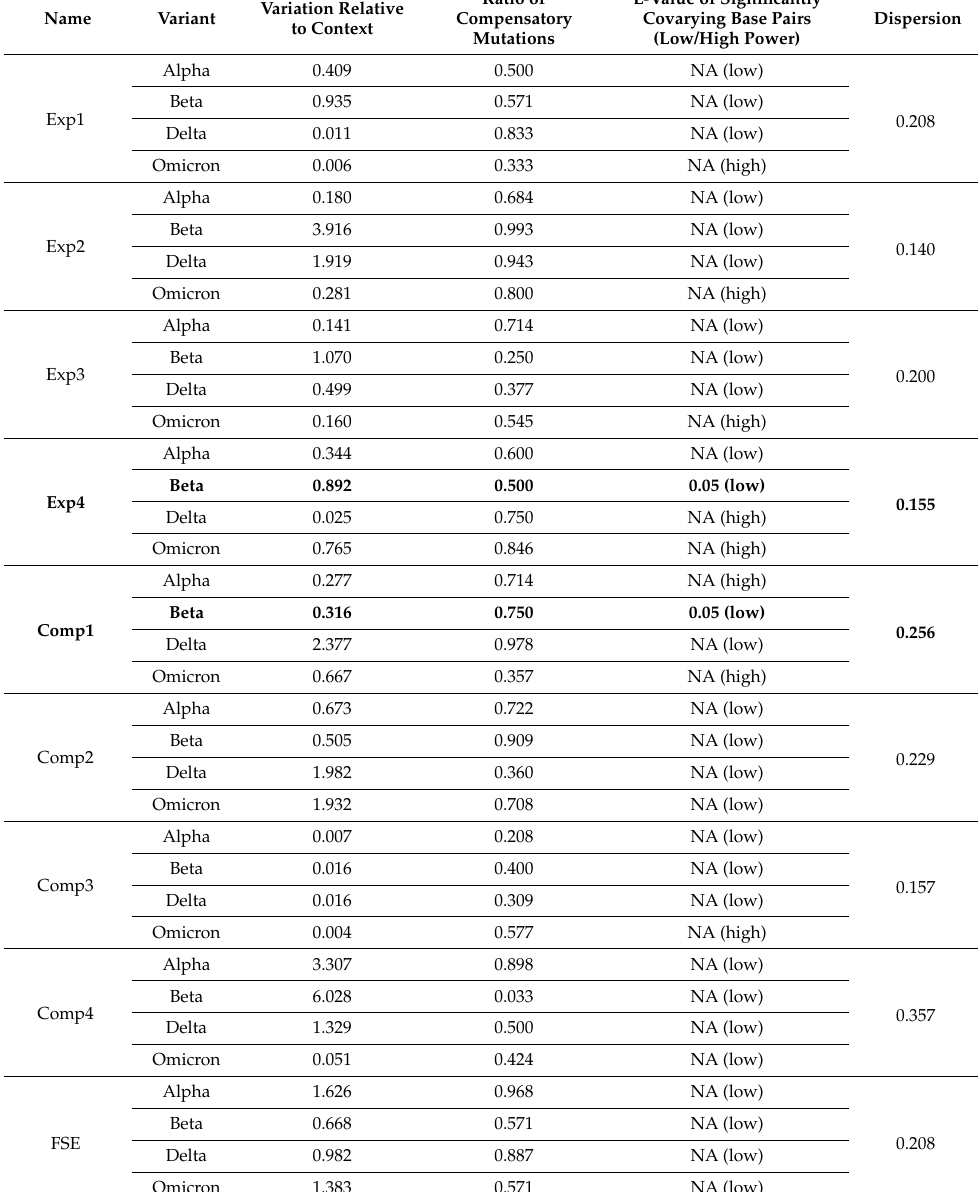
Table 5. Variant-specific analysis of the 8 RRI candidates. Relative variation is normalized by the number of sequences (value of 1 indicates an equal per base variation in the surrounding region, 100nt in each direction). E-value reports the significance value of the R-scape covariation analysis, with the level of power categorized as low if it is reported to be <10% (power is fraction of base pairs expected to covary). Dispersion represents the standard deviation of % compensatory mutations for all